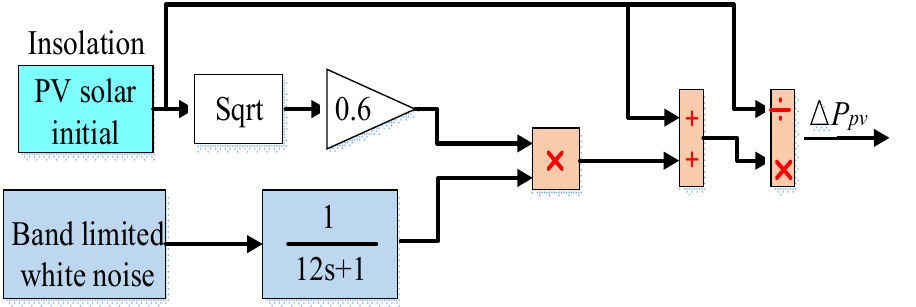
Figure 5. The solar energy modeling using MATLAB/Simulink [44].